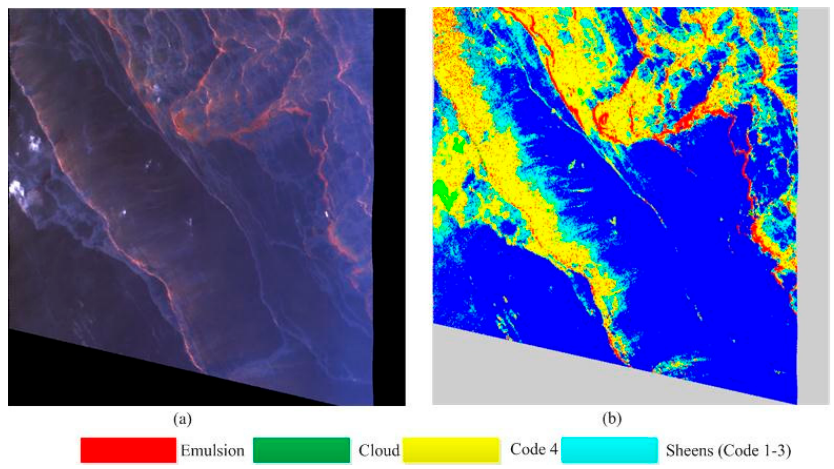
Figure 22. Identification results of another Airborne Visible Infrared Imaging Spectrometer (AVIRIS) image captured on 6 May 2010. Picture ( a ) is the false-color AVIRIS composited image and picture ( b ) is the identification result of it.